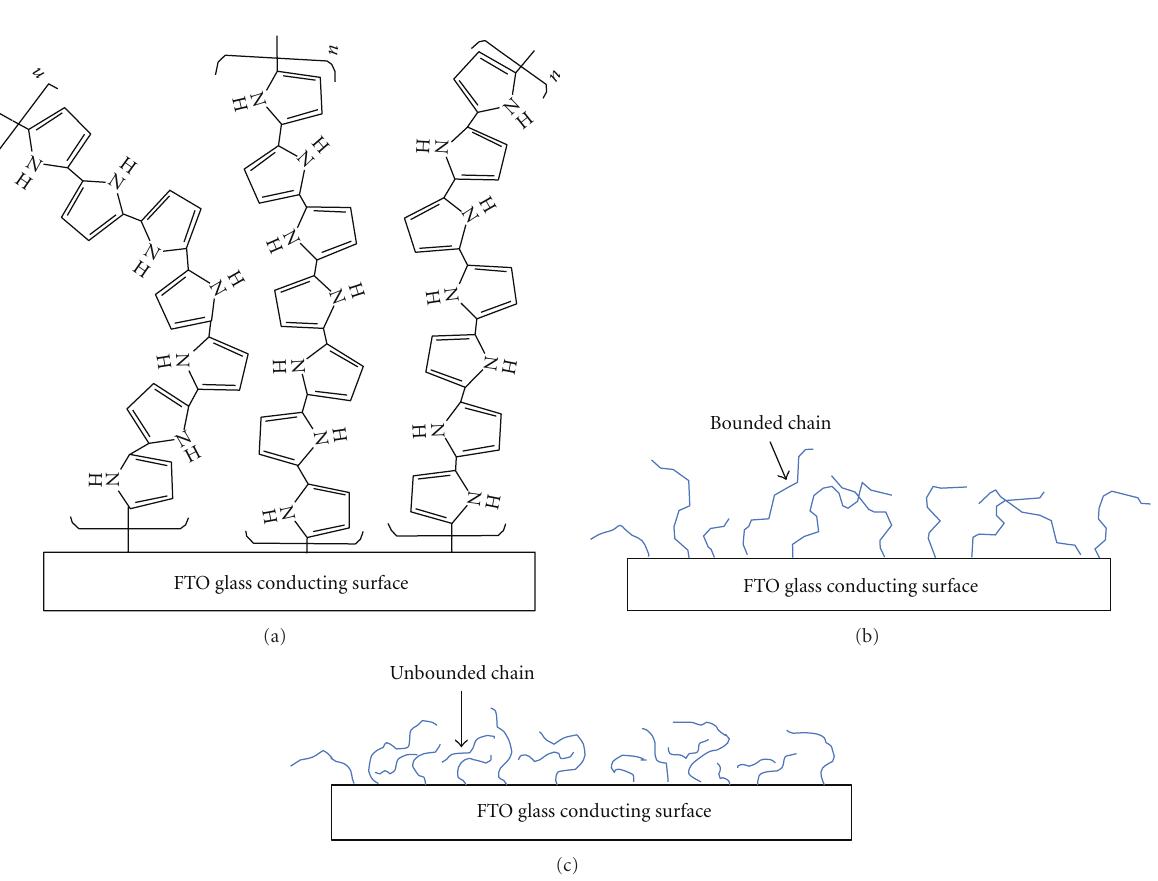
Figure 2: Schematic illustrating PPy formation on FTO glass, (a) PPy chemical structure, (b) PPy coated by AC method, and (c) PPy coated by DC